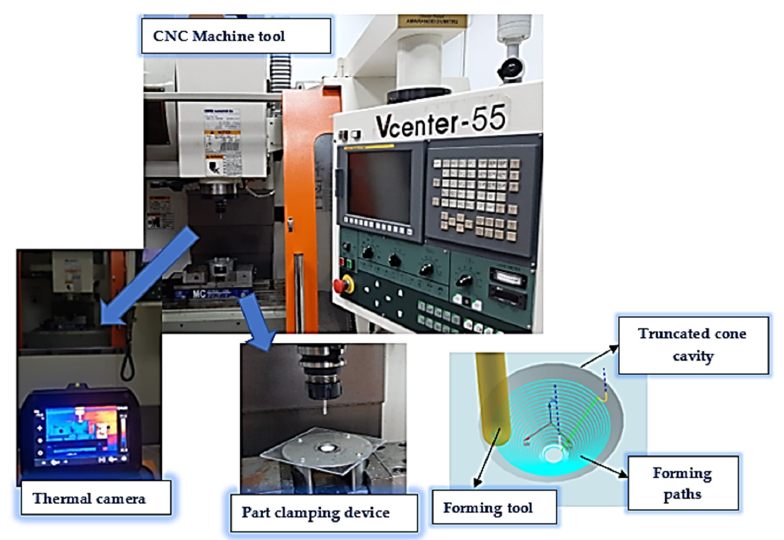
Figure 3. The equipment and conditions on which the single-point incremental forming process was performed.